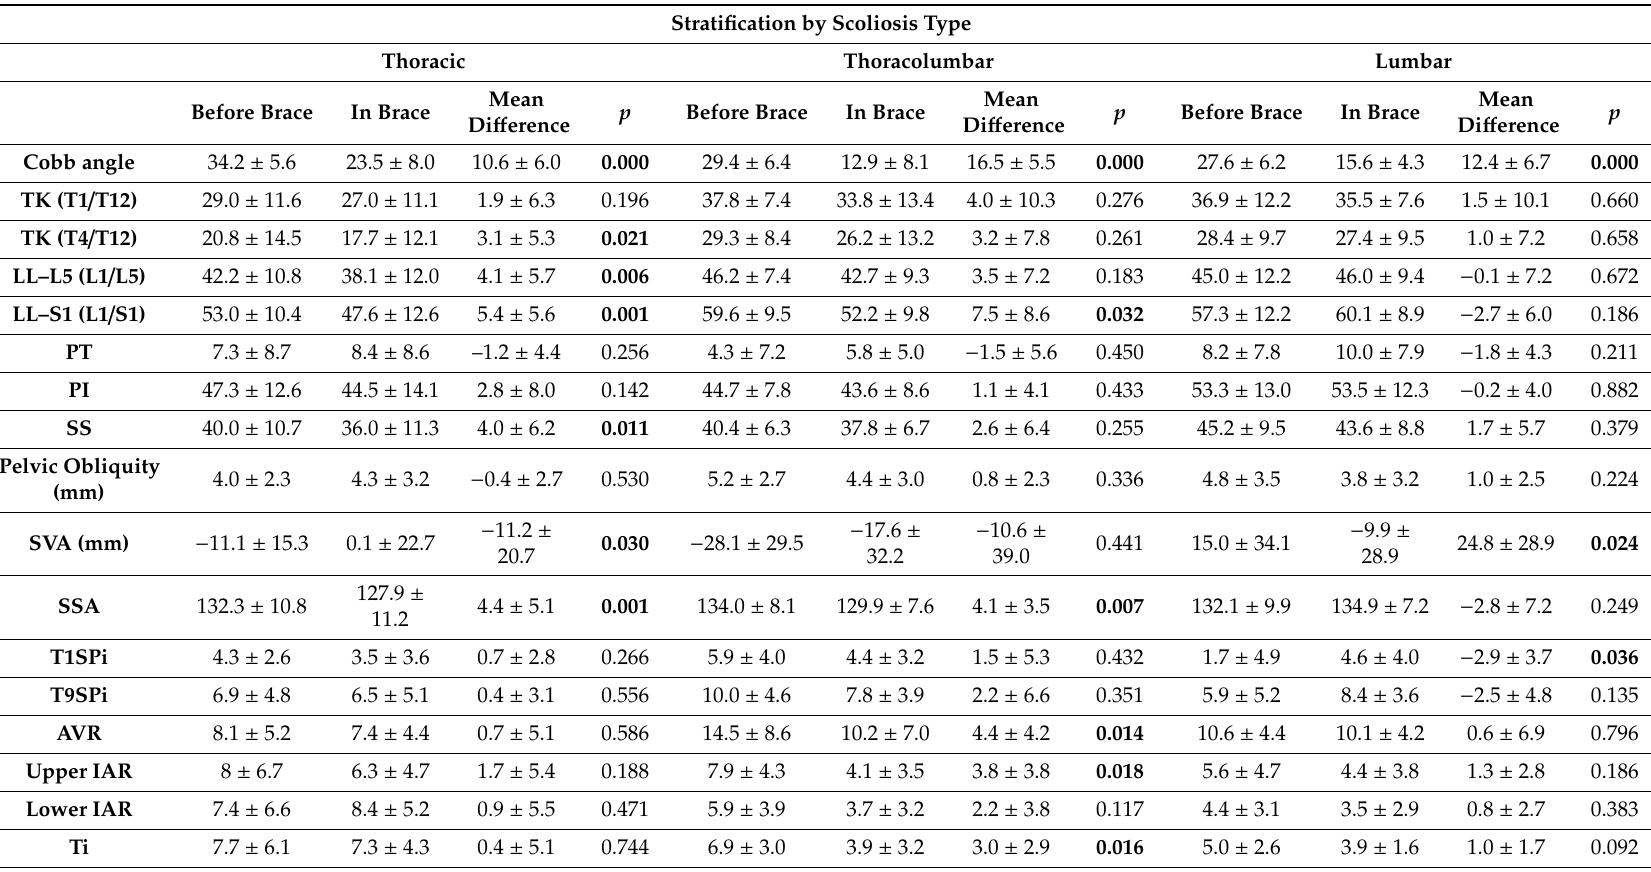
Table 2. Correction of coronal, sagittal and transverse radiographic parameters with the Ch ê neau-type brace. Stratification by Scoliosis Type